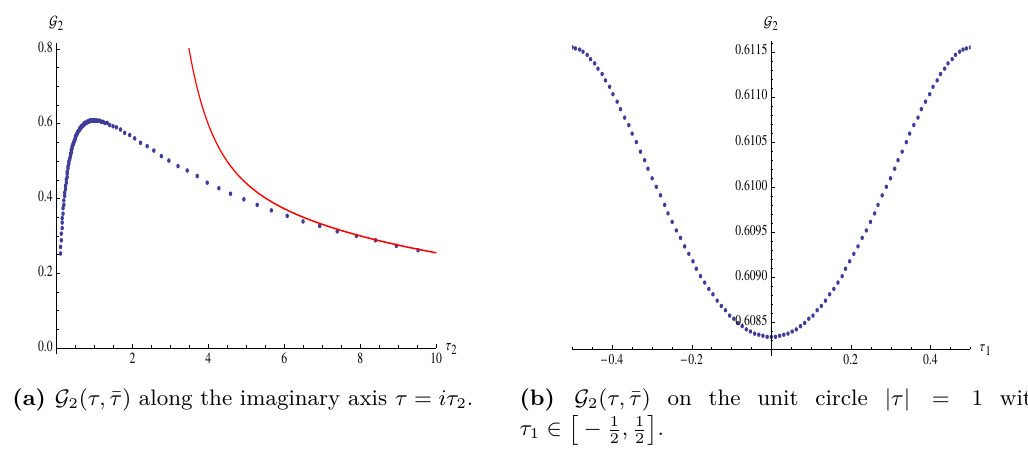
Figure 1. Numerical evaluation of G 2 ( τ, ¯ τ ) in two one-dimensional subspaces of the τ plane. (a) τ takes values on the imaginary axis showing a maximum at τ = i . The red line plots the purely perturbative expansion (3.6) truncated to fifth order. (b) τ takes values on the unit circle | τ | = 1 . The integrated correlator has maxima at τ = exp( πi/ 3) and τ = exp(2 πi/ 3) , and a saddle at τ = i